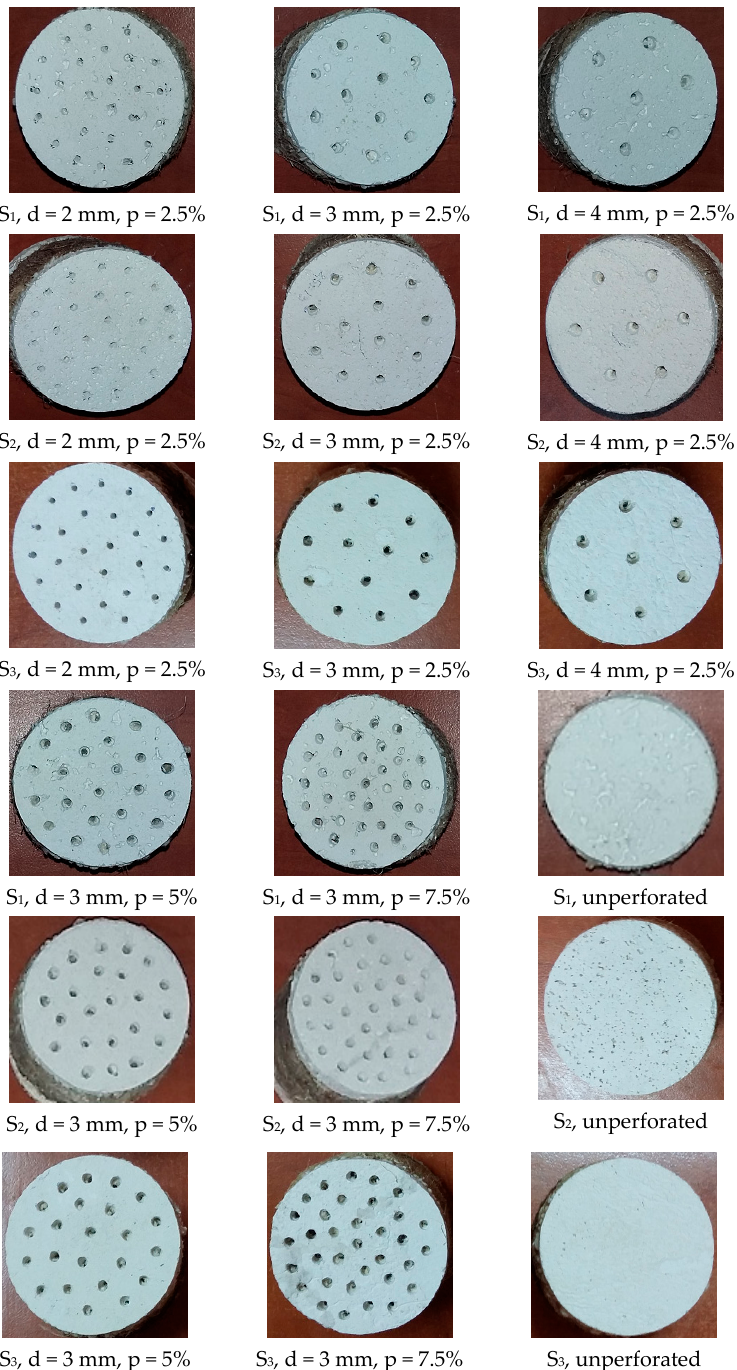
Figure 2. Multi-layered composite samples (S 1 , S 2 , S 3 ): unperforated and perforated with diameter sizes d = 2 mm, 3 mm, 4 mm and perforation percentages p = 2.5%, 5%, 7.5%.